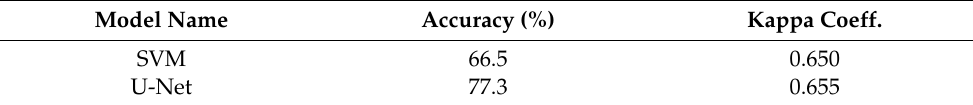
Table 8. Accuracy metrics—overall accuracy (Equation (2)) and kappa coeff. (Equation (3))—based on the predictions of best performing models, SVM and U-Net, compared with the edited map seen in Figure 8. The accuracy of modelsis much lower compared to the accuracy derived from independent testing